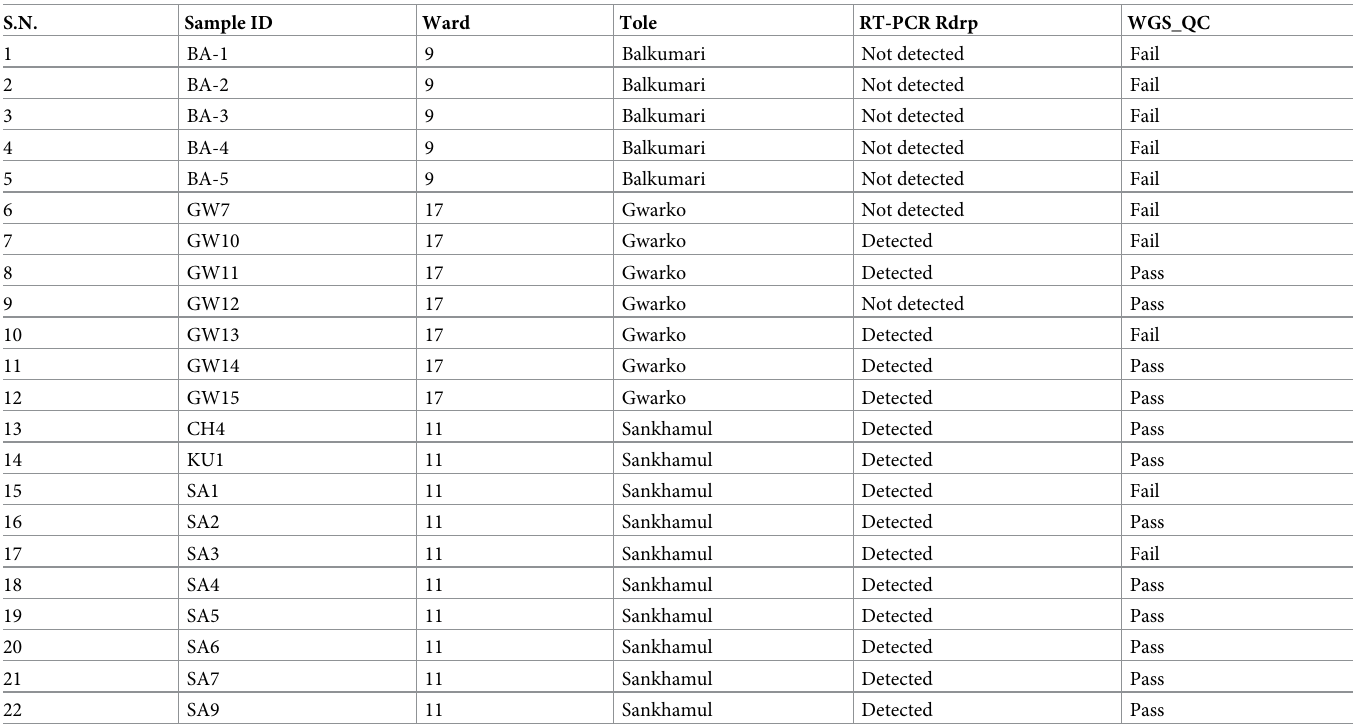
Table 2. Sample details of environmental surveillance in LMC.